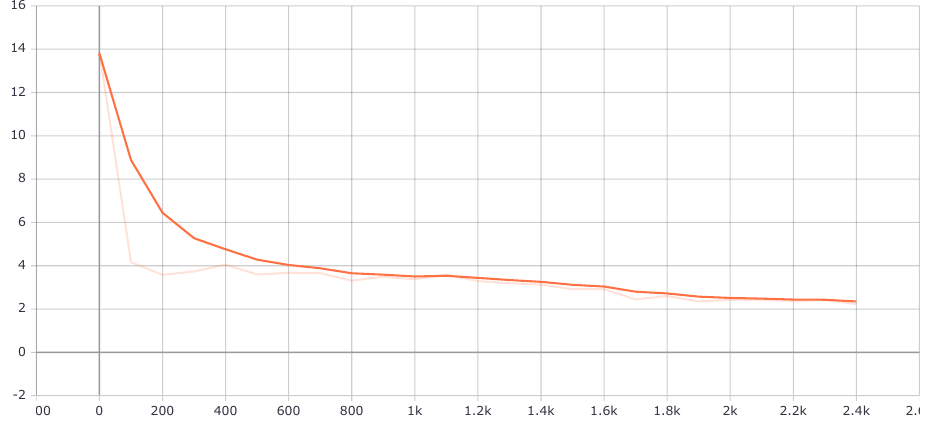
Figure 8. Metrics: mean absolute error of the U-Net model vs.